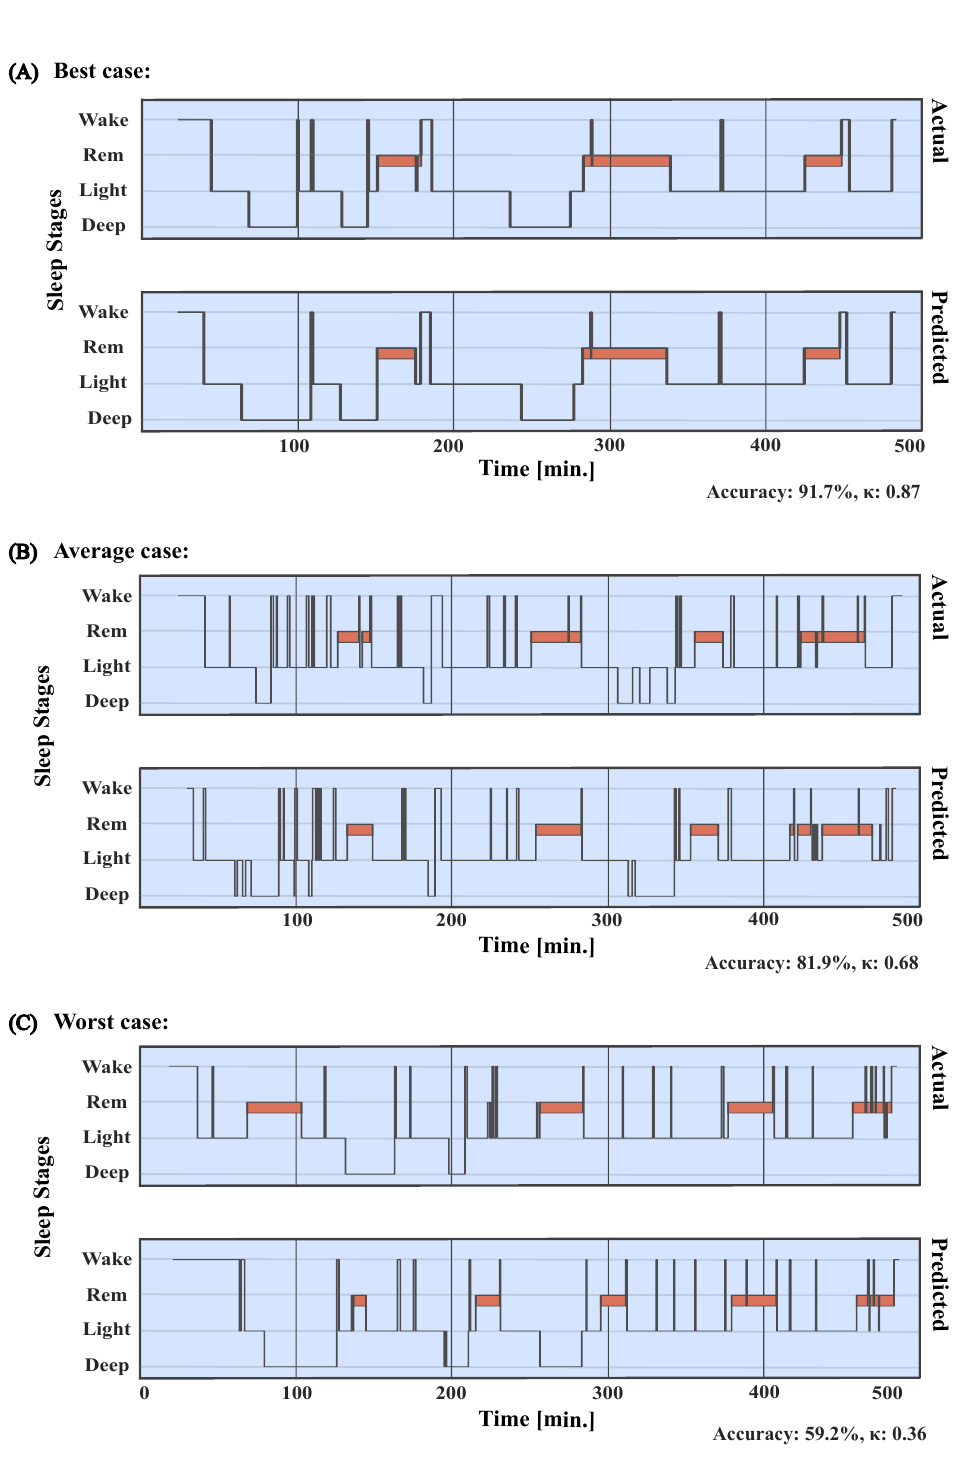
Figure 1. Example of actual and predicted hypnograms for the H10 sensor. The actual hypnograms are sleep-staged based on PSG using the Sleepware G3 software (upper plots), while the predicted hypnograms are based on MCNN sleep stage classification (lower plots) solely trained on the IBIs as extracted from the H10 sensor. We include an example of ( A ) a best classification case (Accuracy: 91.7%, κ : 0.87), as well as ( B ) an average (Accuracy: 81.9%, κ : 0.68) and ( C ) worst case (Accuracy: 59.2%, κ : 0.36)